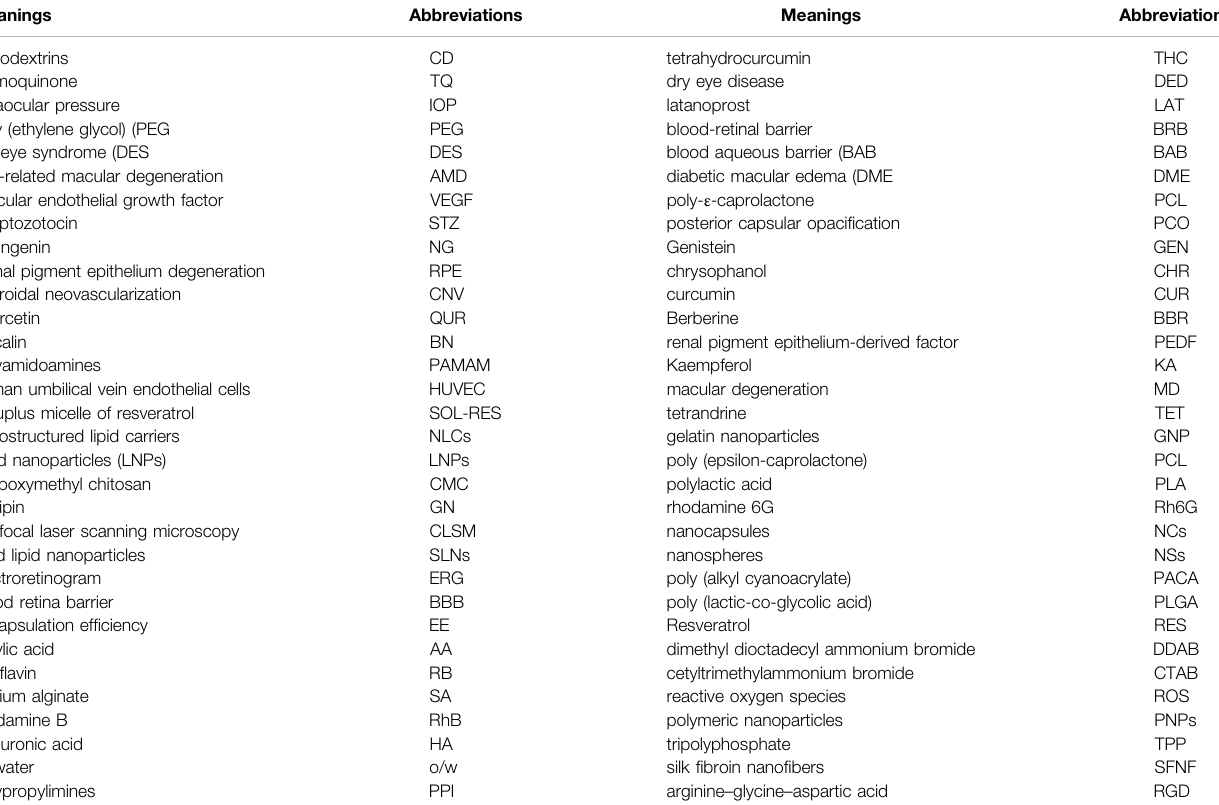
TABLE 2 | List of abbreviations. For easy reading abbreviations are listed in TABLE 2.